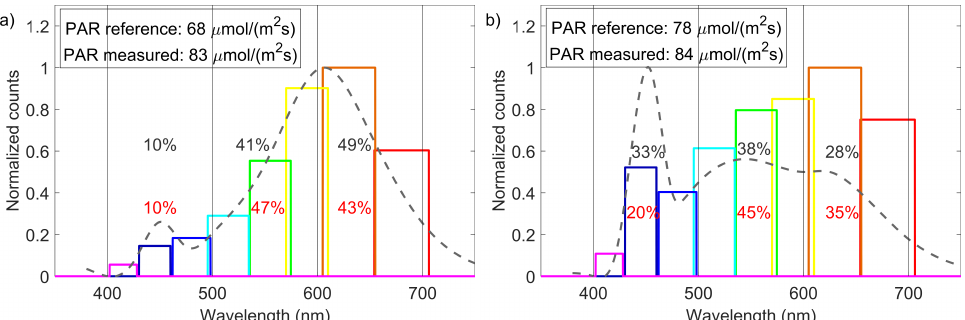
Figure 6. Measured spectral light distribution of a warm ( T = 2700K) white ( a ) and a cold ( T = 5700K) white ( b ) LED, normalized to their highest channel value. The bar widths correspond to the FWHM of the channel sensitivity. The gray-dashed line represents the expected spectrum of the light source (redrawn from the data sheet [24]). The measured and calculated PAR values are listed in the upper left box. The RLQI distribution that is expected is noted in gray, the measured one in